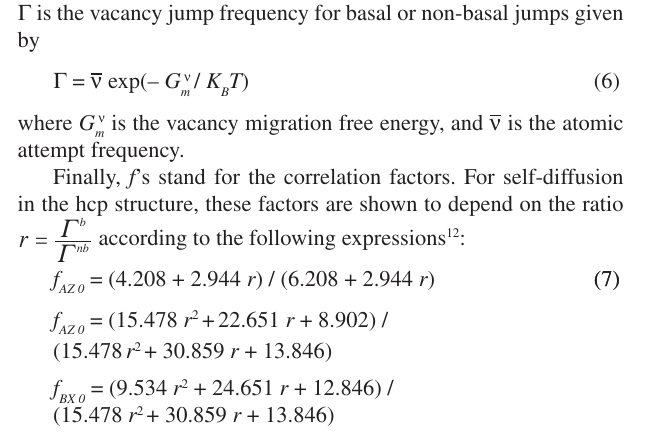
Table 1. V ( x ) (in eV) potential parameters, x